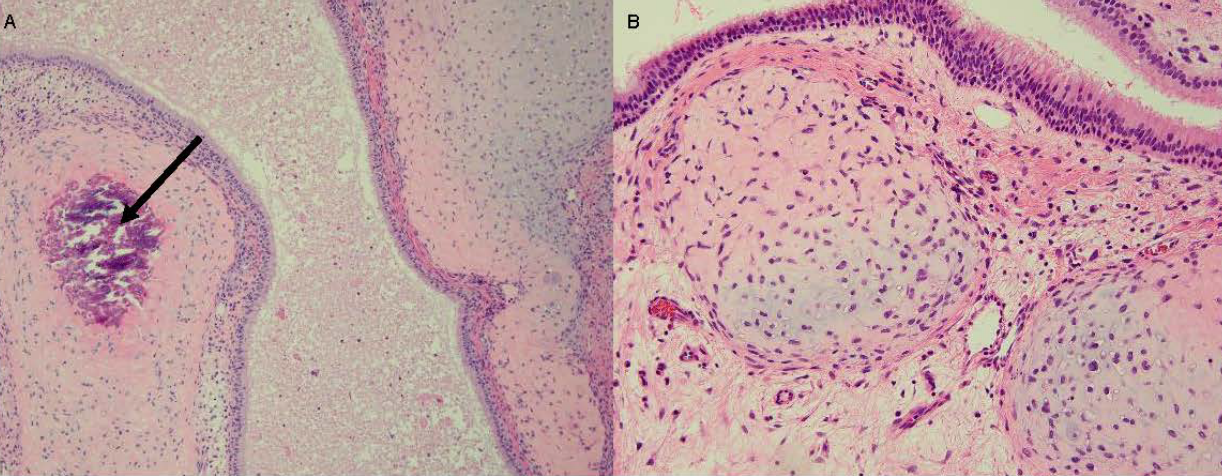
Supplementary Figure 3. Pathology Images (case #64 in Table 2). A: H & E staining of NCMH with focal ossification (arrow) within cartilage island of polypoid nasal mucosa (10x magnification). B: H & E staining of NCMH with cartilage islands in paranasal sinus polypoid mucosa (20x